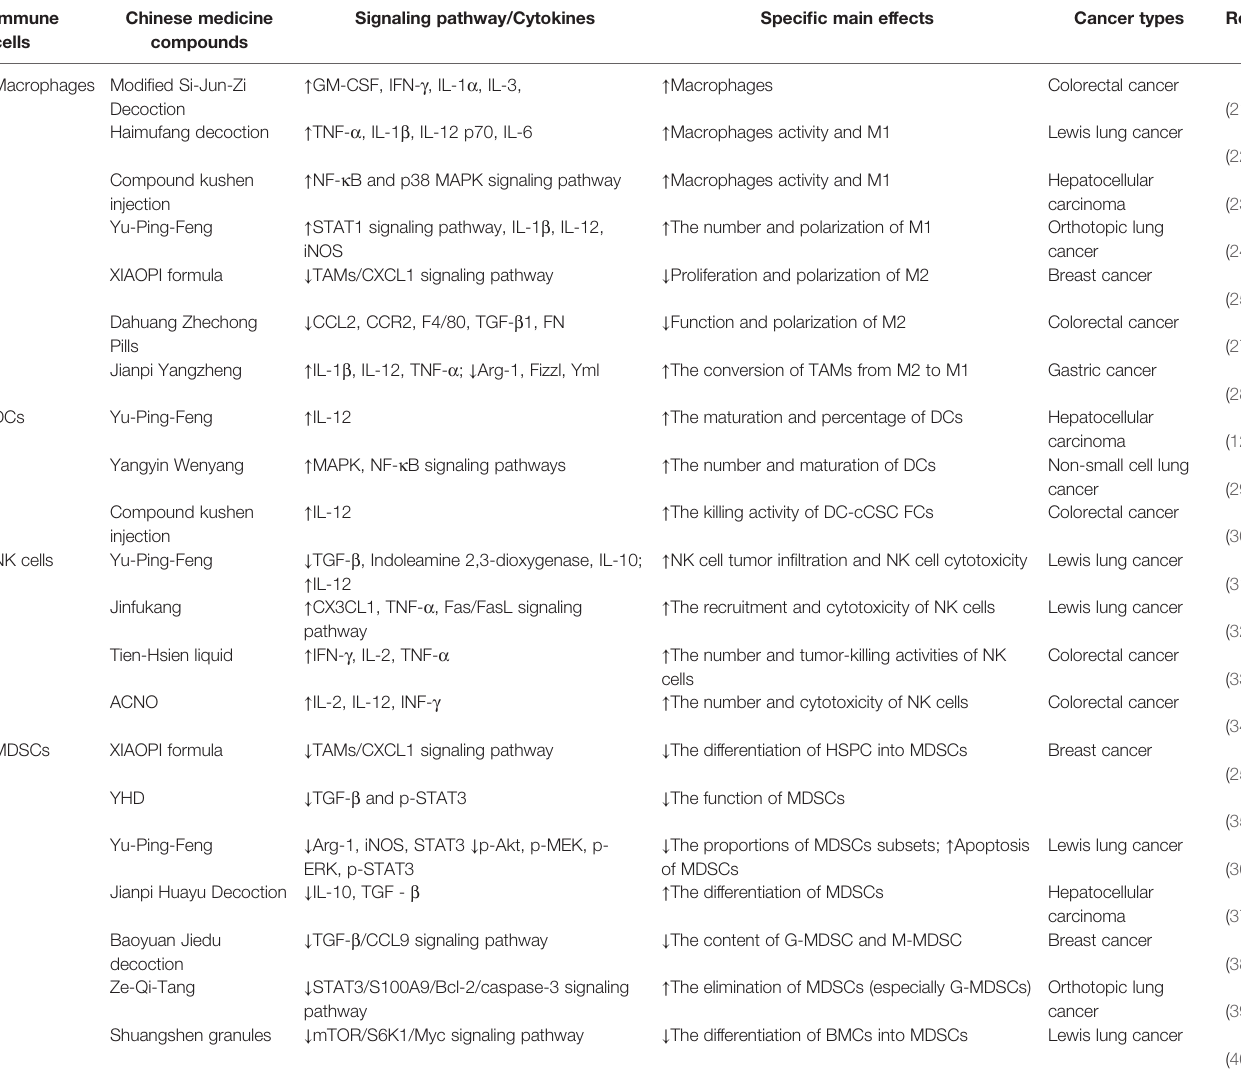
TABLE 1 | Innate immune cells impacted by Chinese medicine compounds. Immune Chinese medicine cells